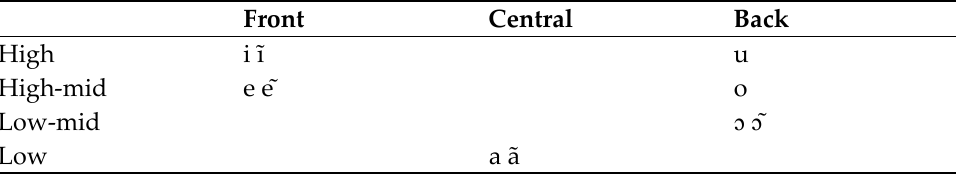
Table 2. Phonemic vowels in Min (Following [27]).